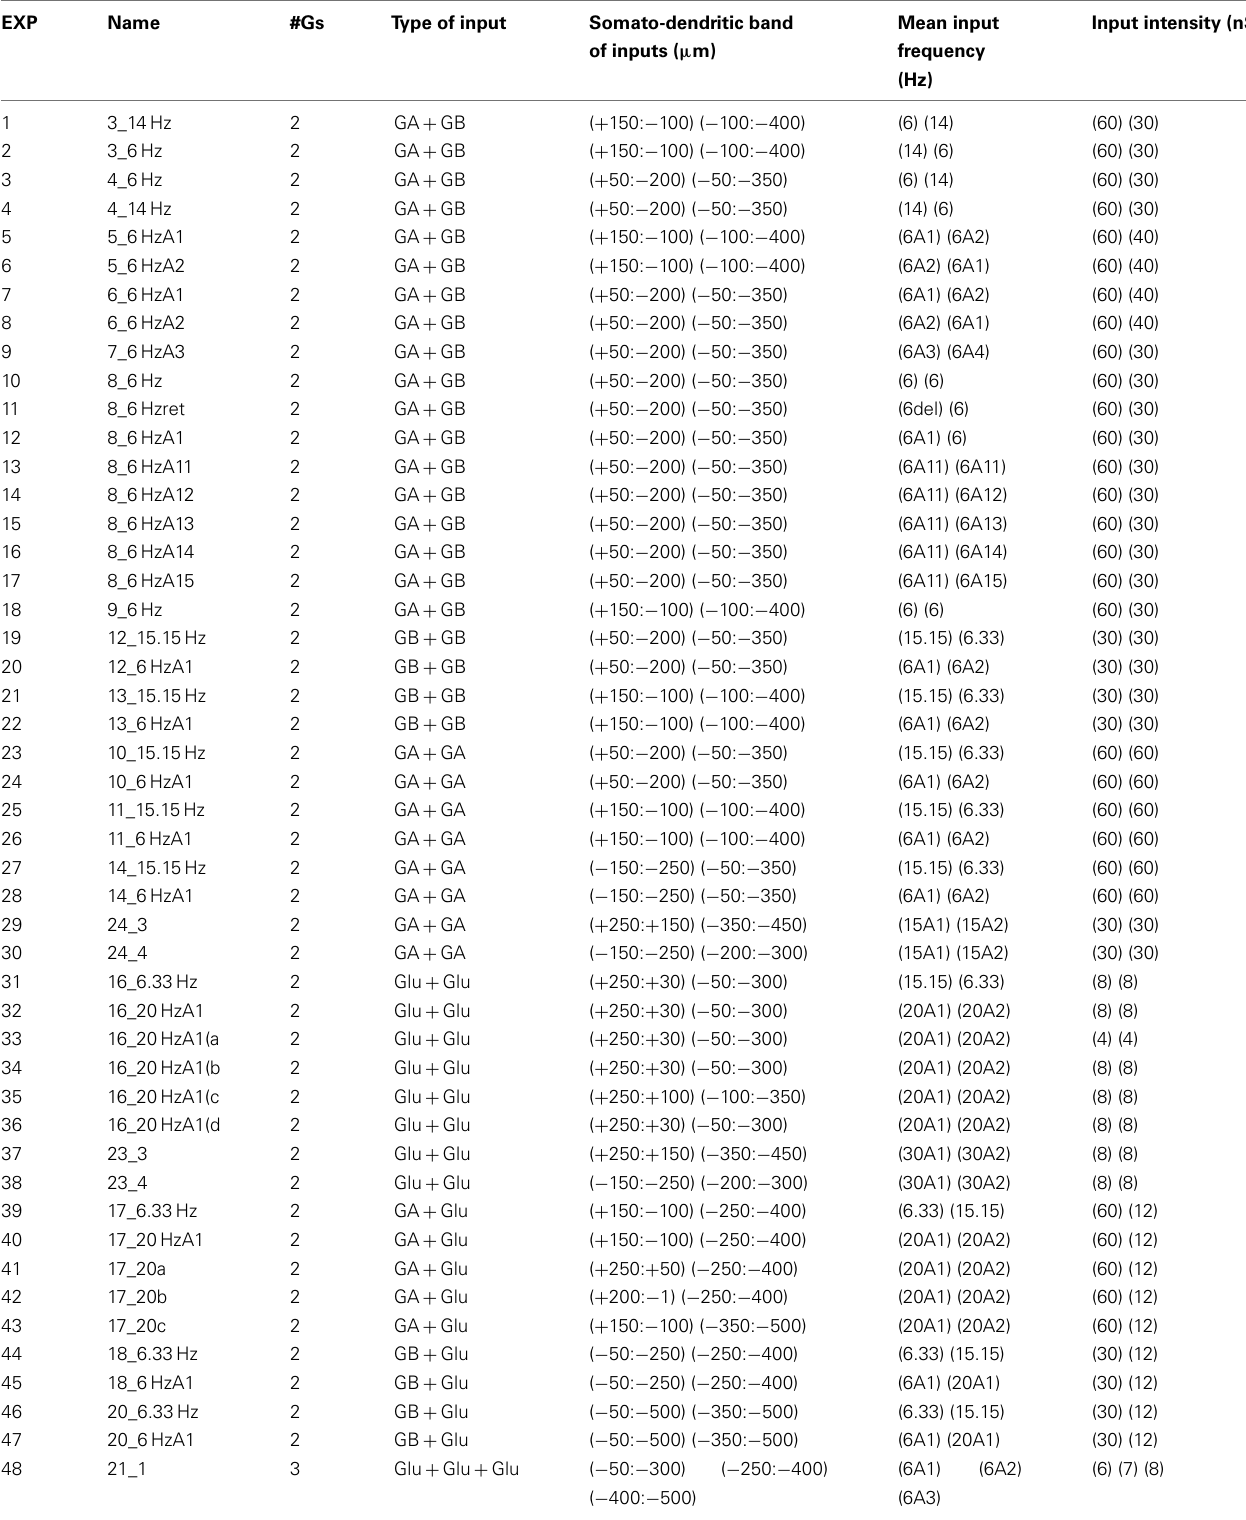
TableA1 | Parameters of the synaptic inputs employed in the simulation of